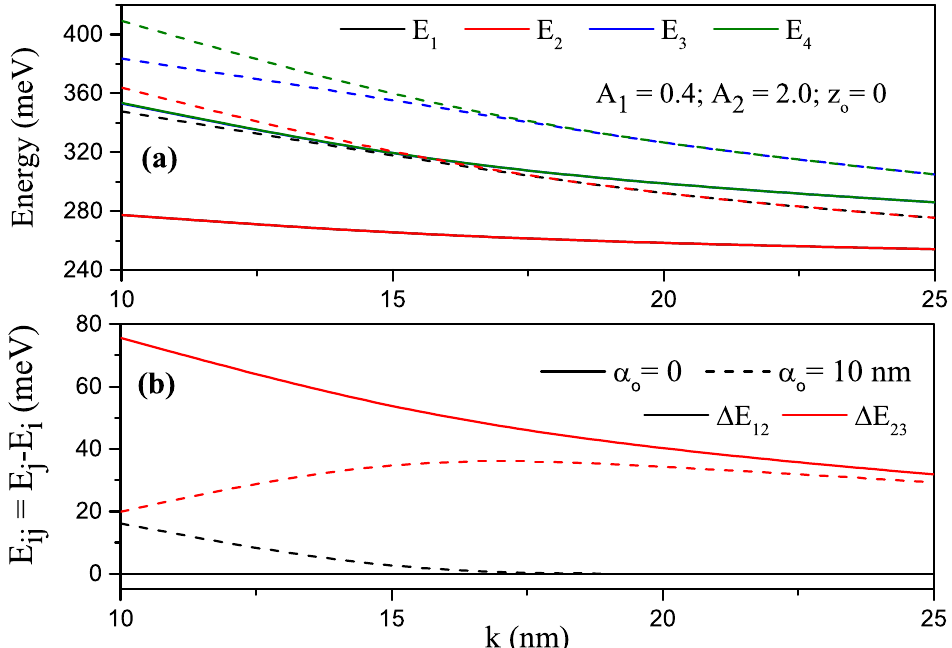
Figure 4. For A 1 = 0.4, A 2 = 2.0 and z o = 0, ( a ) changes in the energies of the electron confined within parabolic–Gaussian symmetric DQW under the intense laser field versus the k parameter; ( b ) variation of energy differences between related levels versus the k parameter. Solid and dashed curves are for α o = 0 and α o = 10nm,